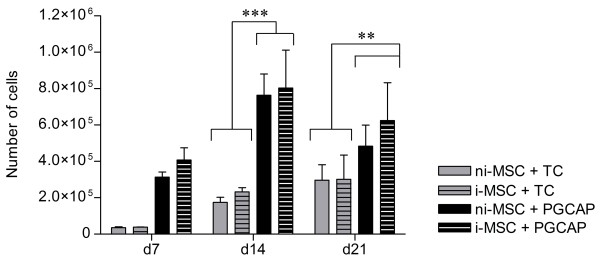
PGCAP promotes mesenchymal stromal cell (MSC) and osteoprogenitor proliferation. Not induced-MSCs (ni-MSCs) or osteogenic induced-MSCs (i-MSCs) were embedded in TC or PGCAP and grown for 21 days. The number of cells was evaluated in each condition at days 7, 10, and 21. Data are expressed as mean ± standard error of the mean. Analysis-of-variance test followed by Student Newman-Keuls test revealed statistically significant difference between groups (PGCAP and TC) at different times. **P <0.01, ***P <0.001. d, day; PGCAP, platelet glue obtained from cryoprecipitation of apheresis platelet products; TC, Tissucol.